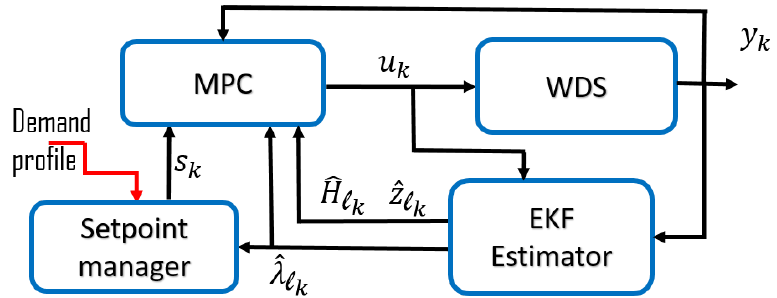
Figure 5. Block diagram representation of MPC used in WDS.